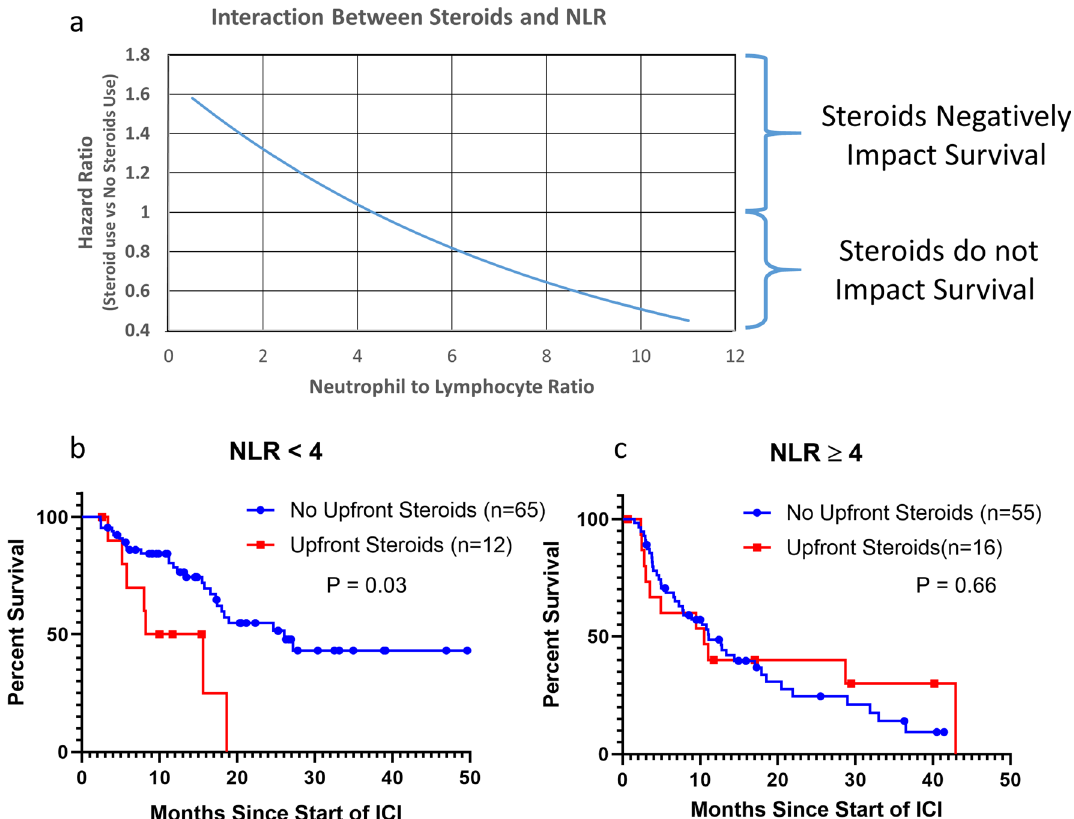
Figure 3. Association of upfront steroids with OS is dependent on NLR. ( a ) A model was generated utilizing known predictors of OS in NSCLCBM, upfront steroid use, NLR as well as an interaction term between NLR and upfront steroids. The hazard ratio of upfront steroid use was calculated at varying NLRs. Impact of upfront steroids was then analyzed based on NLR less than 4 ( b ) and NLR greater than or equal to 4 ( c